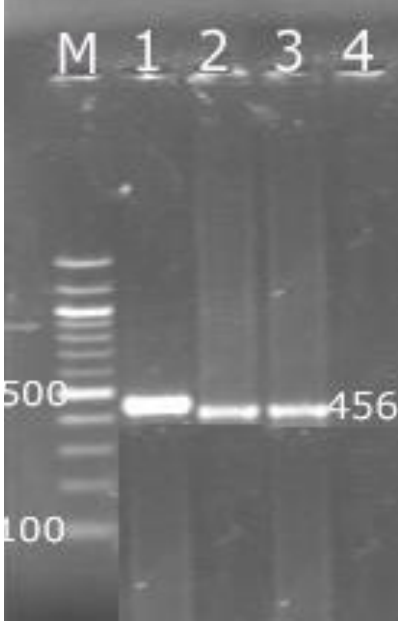
Figure 2. Polymerase chain reaction (PCR) products of hlyA fragments from Listeria monocytogenes. Lane M = DNA ladder 50 bp; Lane 1 and 2 = positive samples with specific bands at 456 bp; Lane 3 = positive control ( L. monocytogenes ATCC 7644); Lane 4 = negative control.